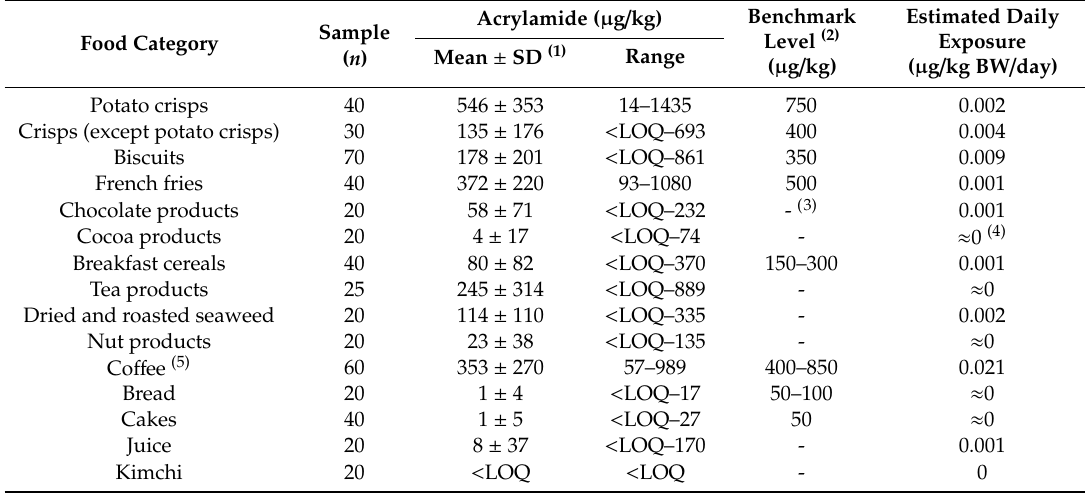
Table 1. Acrylamide contents and estimated daily exposure in food